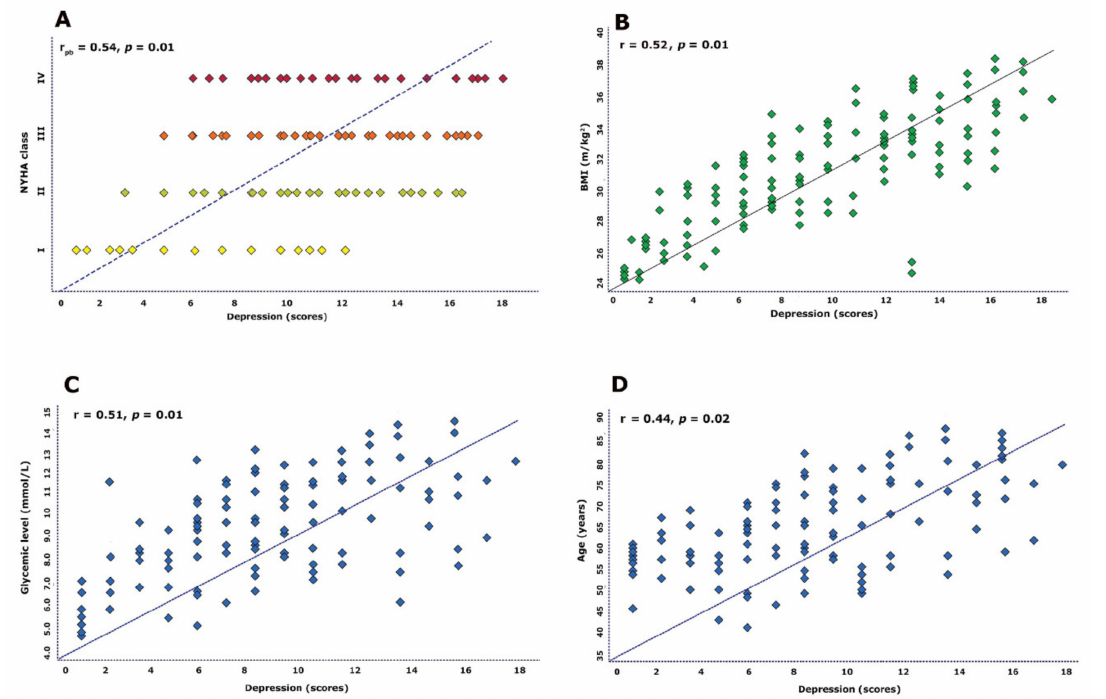
Figure 1. Correlation of demographic and clinical indices with depression; ( A ) correlation between New York Heart Association class (NYHA) class and depression; ( B ) correlation between Body mass index (BMI) and depression; ( C ) correlation between glycemic level and depression; ( D ) correlation between age and